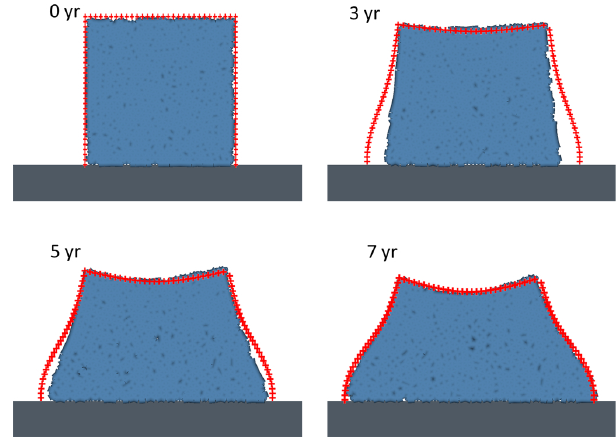
Fig. 5. Snapshots of a deforming ice block simulated with Elmer/Ice and our particle model. In the Elmer/Ice simulation (red markers) the snapshots are from time steps 0, 3, 5 and 7yr and the particle model snapshots (red area) are from corresponding time steps. The size of the block is 30m × 30m and the time span of the Elmer/Ice simulation is roughly 10 8 s but only 10 3 s in the particle